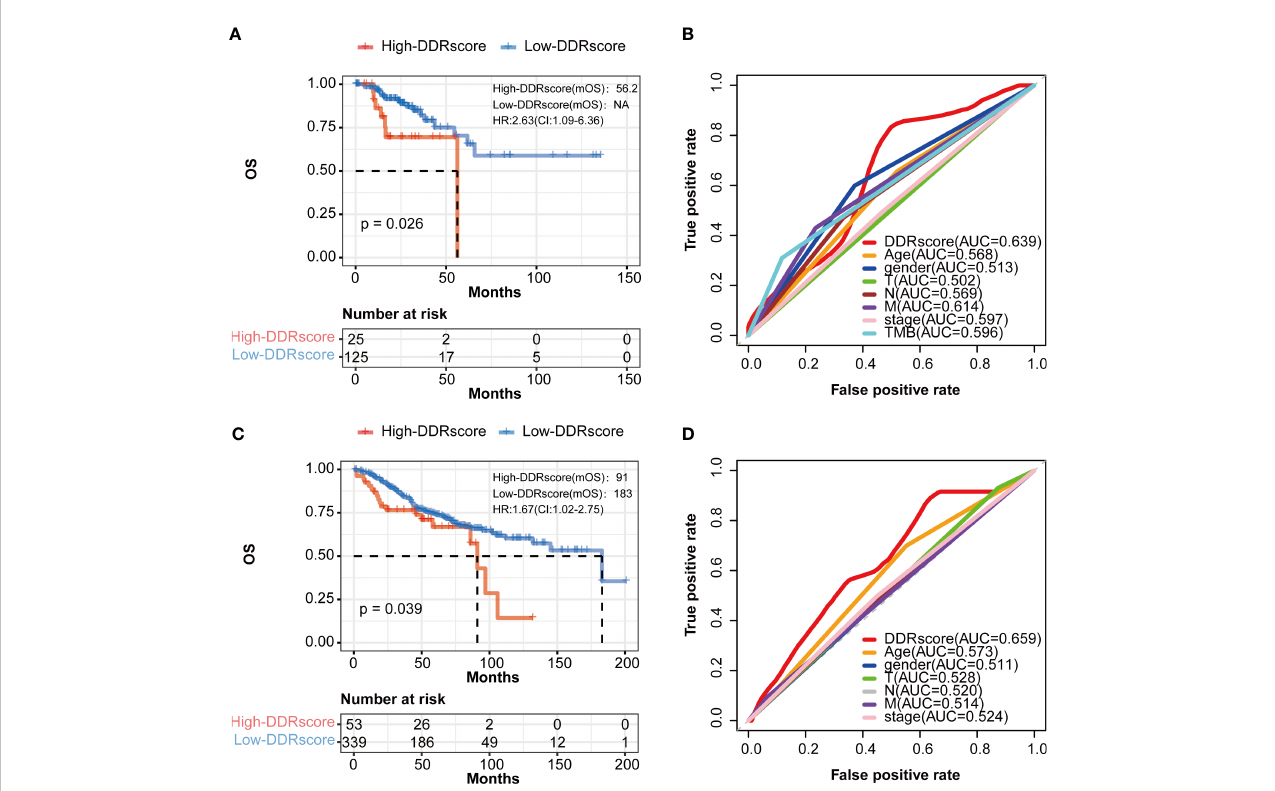
FIGURE 6 The prognosis of patients with CRC was predicted using the DDRscore in validation datasets. (A) Kaplan – Meier analytical evaluation of the prognostic values of DDRscore of mCRC patients from validation dataset of TCGA-COAD. (B) Time-dependent receiver operating characteristic curves for the prognostic model based on theDDRscore in the TCGA – COAD (stage III/IV). (C) Kaplan – Meier analytical evaluation of the prognostic values of DDRscore of CRC patients from validation dataset of GSE39582. (D) Time-dependent receiver operating characteristic curves for the prognostic model based on DDRscore in the GSE39582